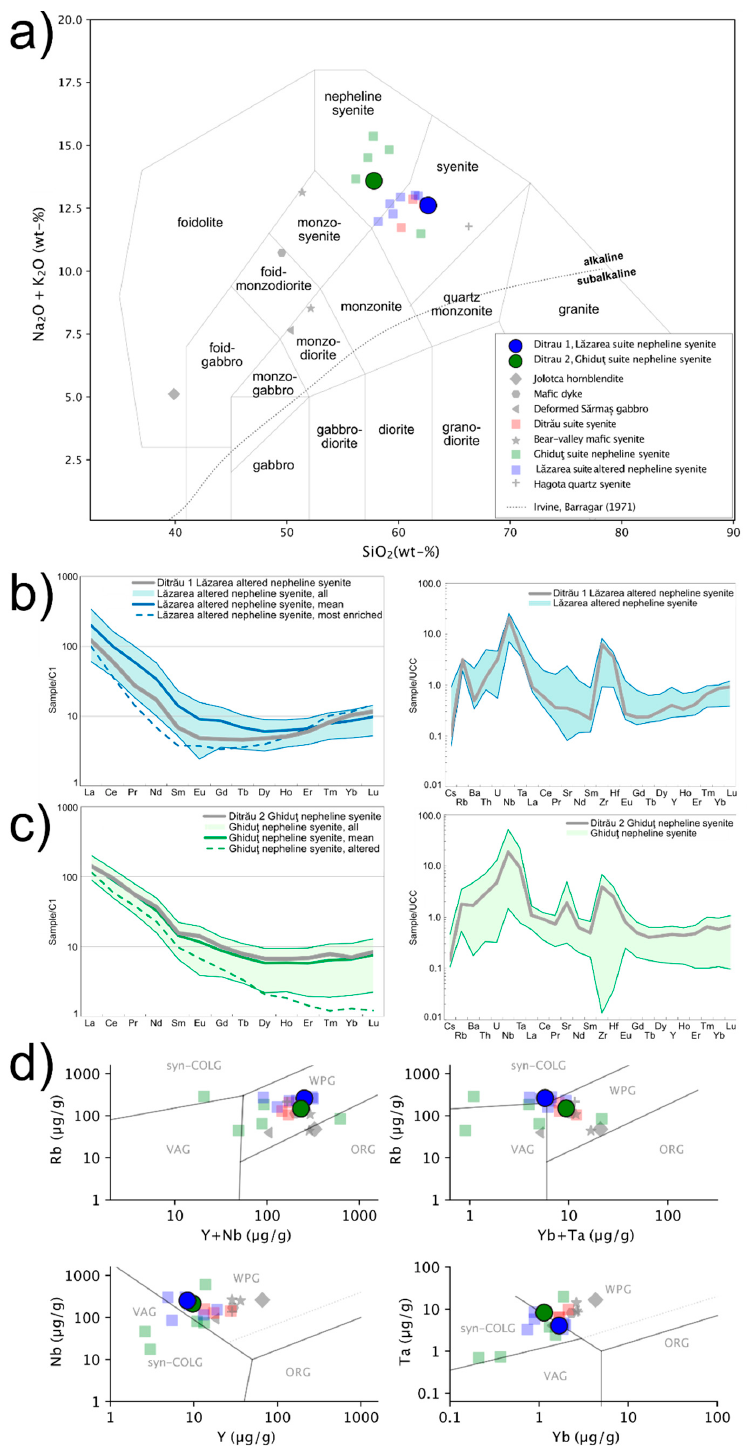
Figure 3. Geochemistry plots. The data are given in Table 1. ( a ) TAS classification after [45]. Blue dot: Ditr ă u 1, L ă zarea suite nepheline syenite; green dot: Ditr ă u 2, Ghidu¸t suite nepheline syenite. Literature data shown in light shading are from [17]. ( b ) Chondrite-normalized REE concentrations using the values of [48]. Blue field: literature data of the L ă zarea suite; green field: literature data of the Ghidu¸t suite. The respective thick gray lines are the data from this study. Literature data are from [17] and [23]. ( c ) Trace element spider diagrams with values normalized to the average upper continental crust of [48]. Blue field: literature data of the L ă zarea suite; green field: literature